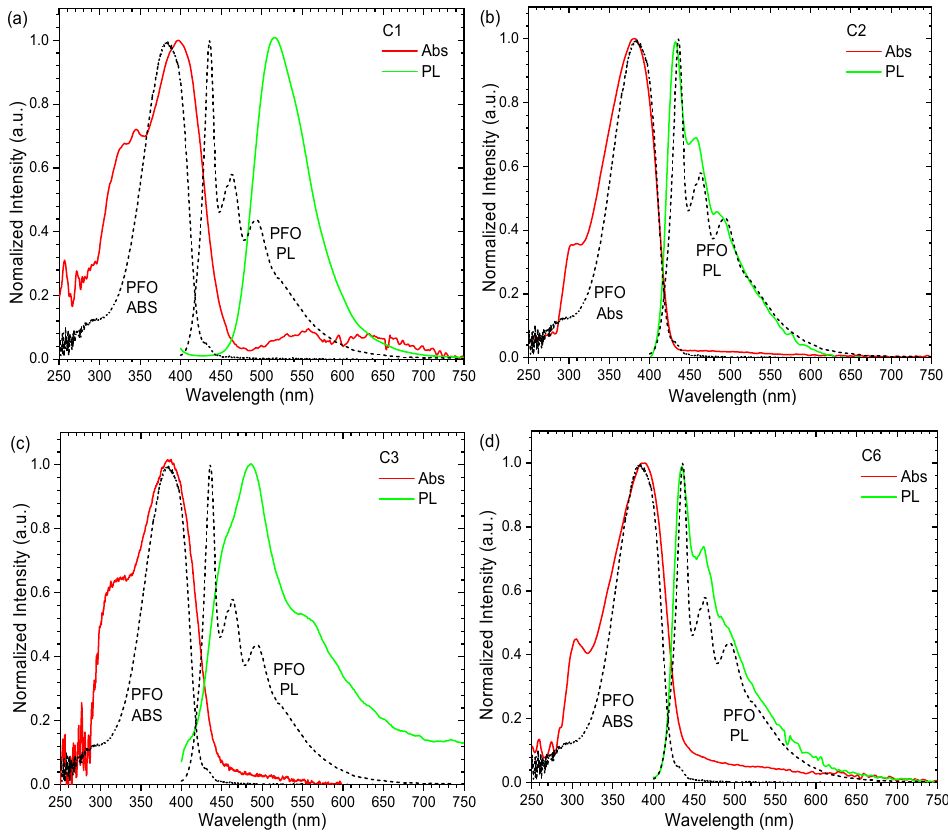
Figure 8. Absorbance and PL of the polymer films ( a ) C1, ( b ) C2, ( c ) C3, and ( d ) C6 as compared to a PFO film (black dotted line).